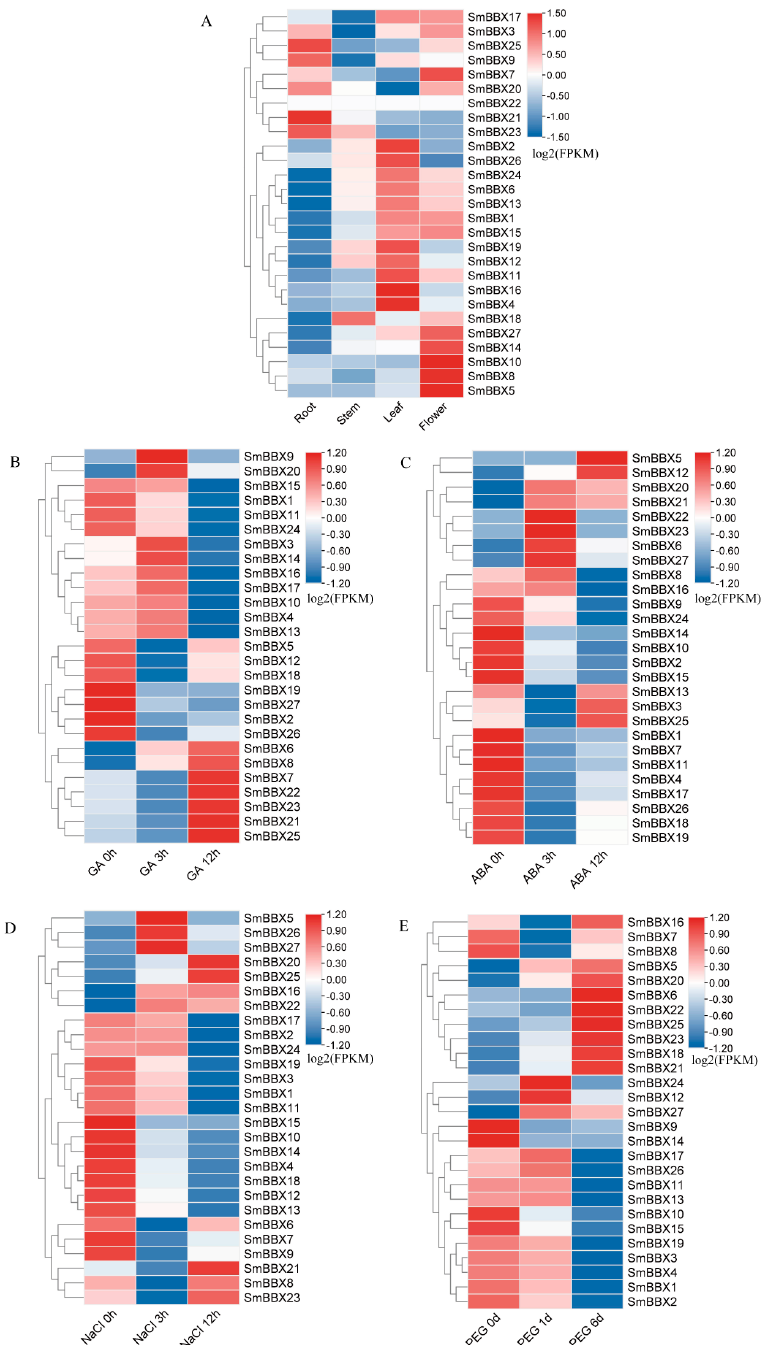
Figure 9. Expression profiles of SmBBX genes in Salvia miltiorrhiza . ( A ) Expression patterns of Salvia miltiorrhiza roots, stem, leaves, and flowers. ( B ) Expression patterns of Salvia miltiorrhiza at 0 h, 3 h, and 12 h following GA treatment. ( C ) Expression patterns of Salvia miltiorrhiza at 0 h, 3 h, and 12 h after ABA treatment. ( D ) Expression patterns of Salvia miltiorrhiza at 0 h, 3 h, and 12 h after NaCl treatment. ( E ) Expression patterns of Salvia miltiorrhiza at 0 h, 1 day, and 6 days after PEG treatment. Blue and red indicate downregulated and upregulated expression levels, respectively, compared to the relevant controls (0 h). The bar on the top right corner represents log 2 transformed